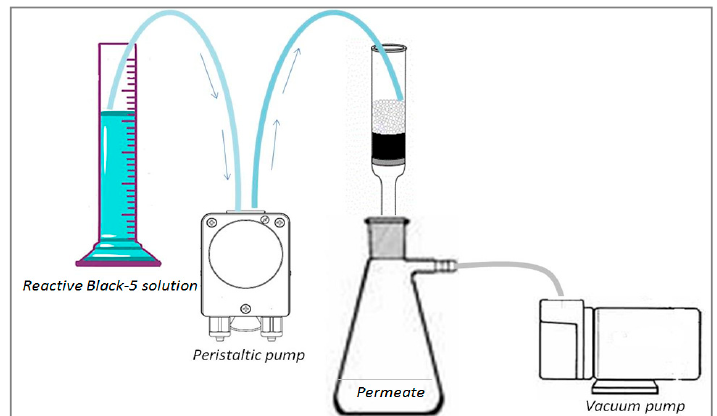
Figure 2. Scheme of the adsorption system.